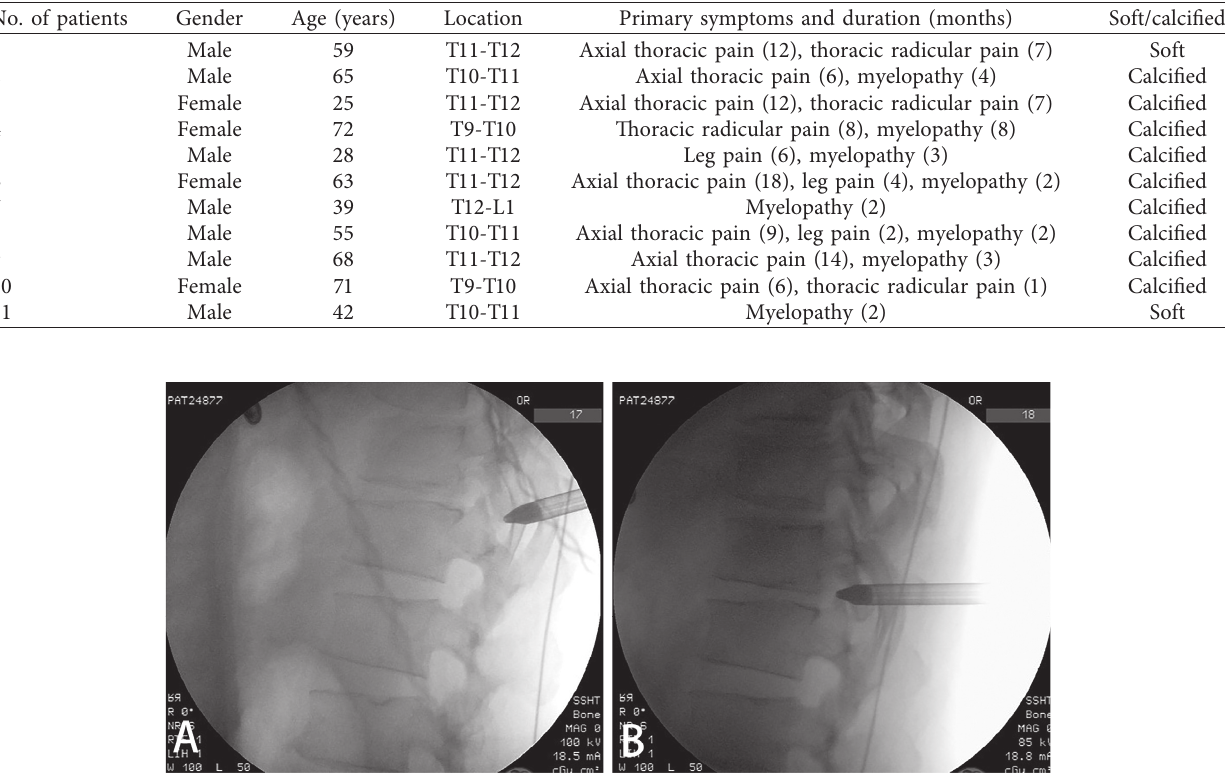
Figure 1: Images of X-ray fluoroscopy showing the dilator punching procedure: a dilator with blunt tip located on the lateral side of the articular process (a). The dilator slid into the lower part of the intervertebral foramen (b).